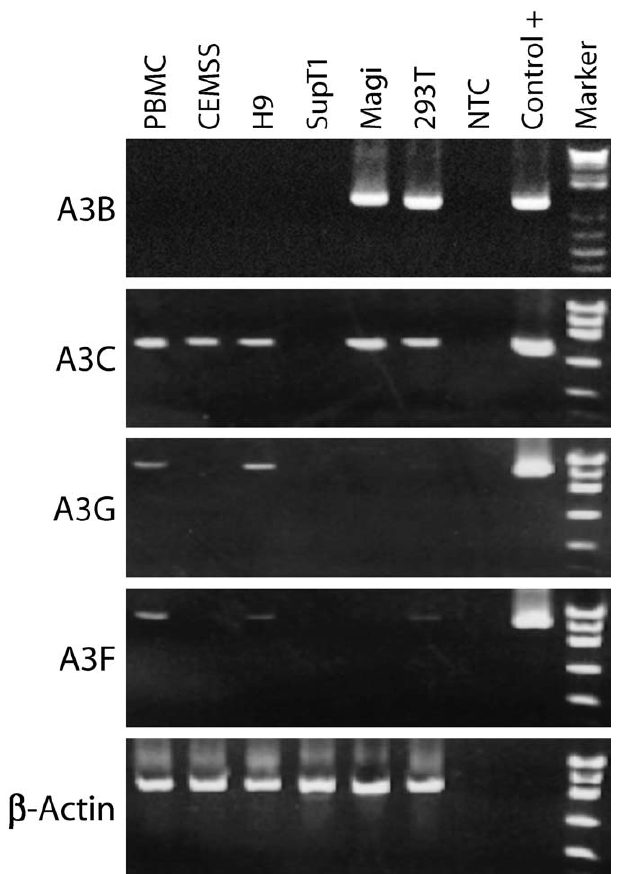
Figure 1. Expression of APOBEC mRNAs in Different Cells Poly A þ RNA was isolated from individual cell types and APOBEC reading frames (A3B, A3C, A3F, and A3G) were amplified with primers specific for a single ORF. The specificity of the primers was verified by sequencing the PCR products. RT-PCR reactions for A3B, A3C, A3G, and A3F ORFs were analyzed by agarose gel electrophoresis. PCR templates were cDNAs for the indicated cell types or plasmids specific for A3B, A3C, A3G, or A3F (positive controls). Water was the nontemplate control (NTC), b - actin was the internal control, and reactions lacking reverse transcriptase (RT) were also used as control during cDNA preparation (unpublished